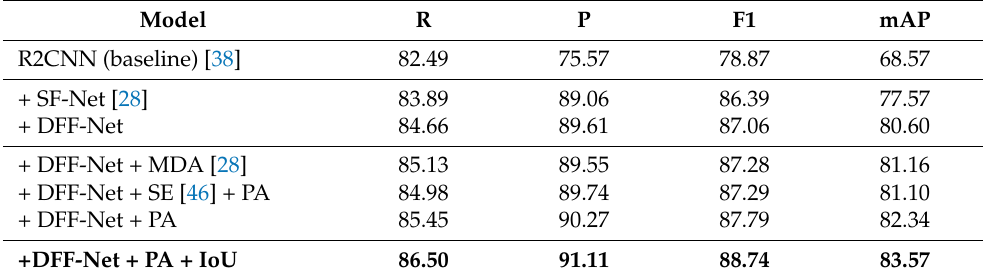
Table 4. In the RD task, the ablation study of each component in our proposed method.